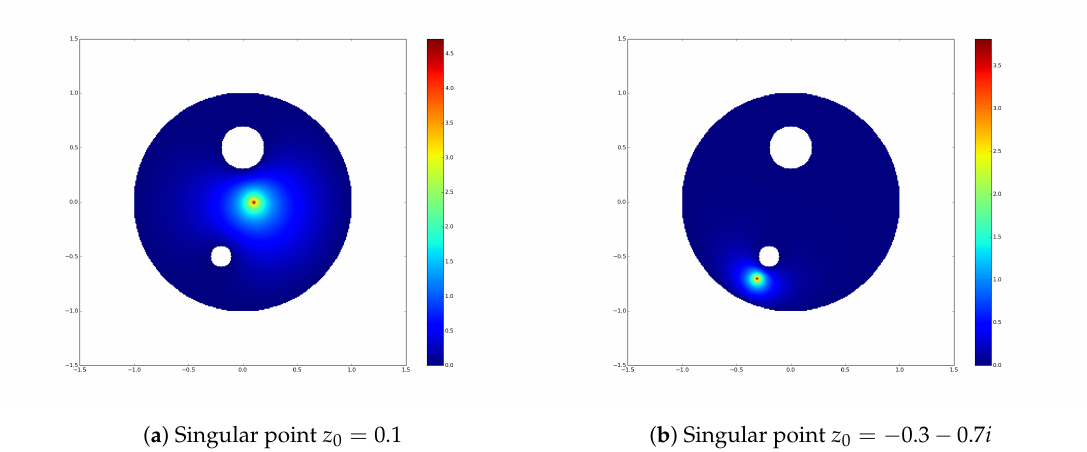
Figure 7. Approximation g of the Green’s function on unit disc with obstacle of radius 0.1 centered at − 0.2 − 0.5 i and destination disc of radius 0.2 centered at 0.5 i .